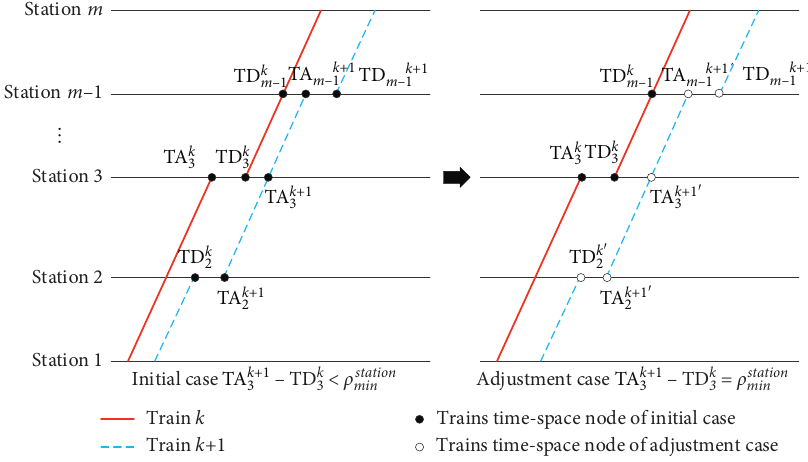
Figure 10: Adjustment method of station